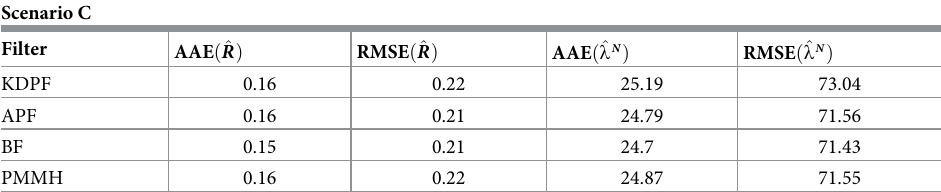
Table 3. Average Absolute Error and Root Mean Square Error for the reproduction number and the latent inten- sity in scenario C. Scenario